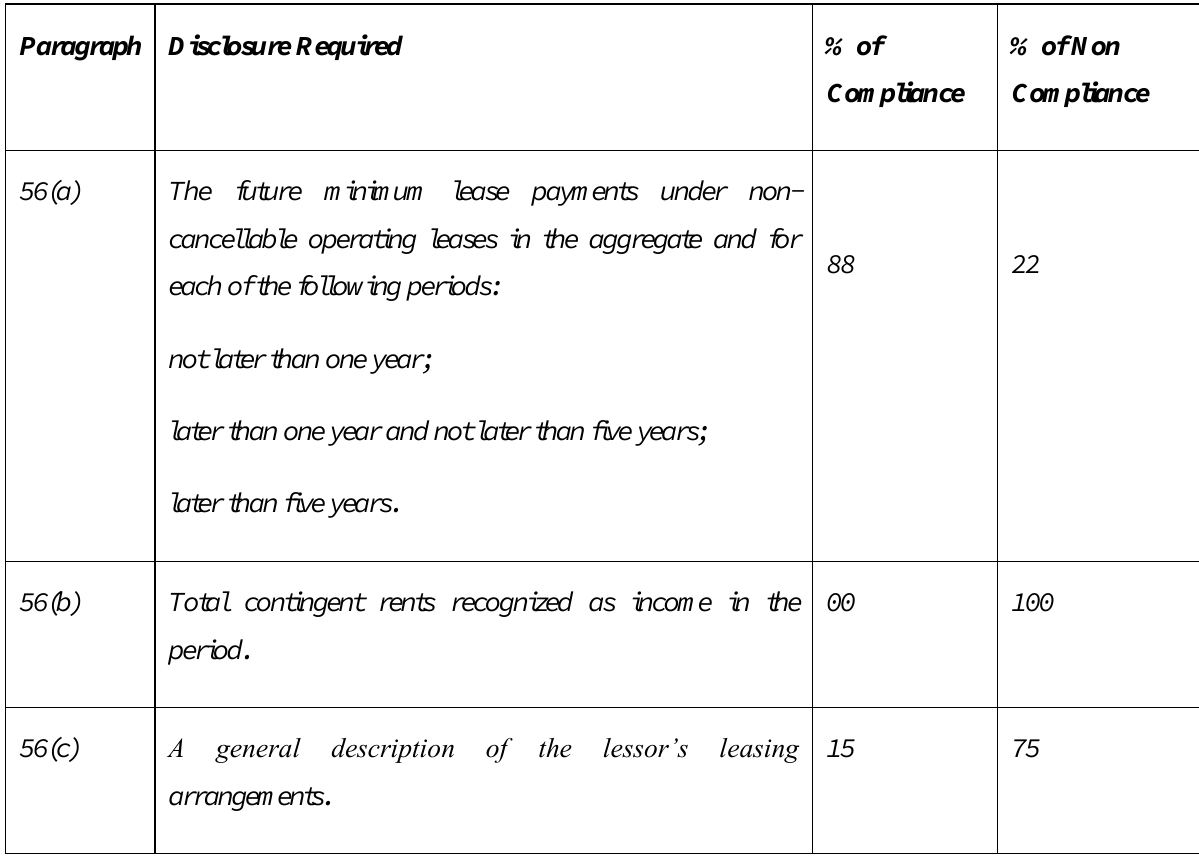
Table 04: Checklist as per paragraph 56 of LKAS